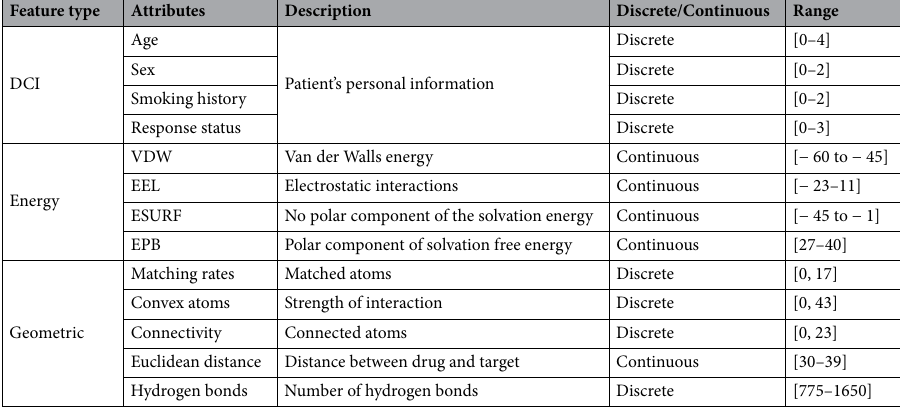
Table 1. Clinical information, energy and geometrical features: description and values.